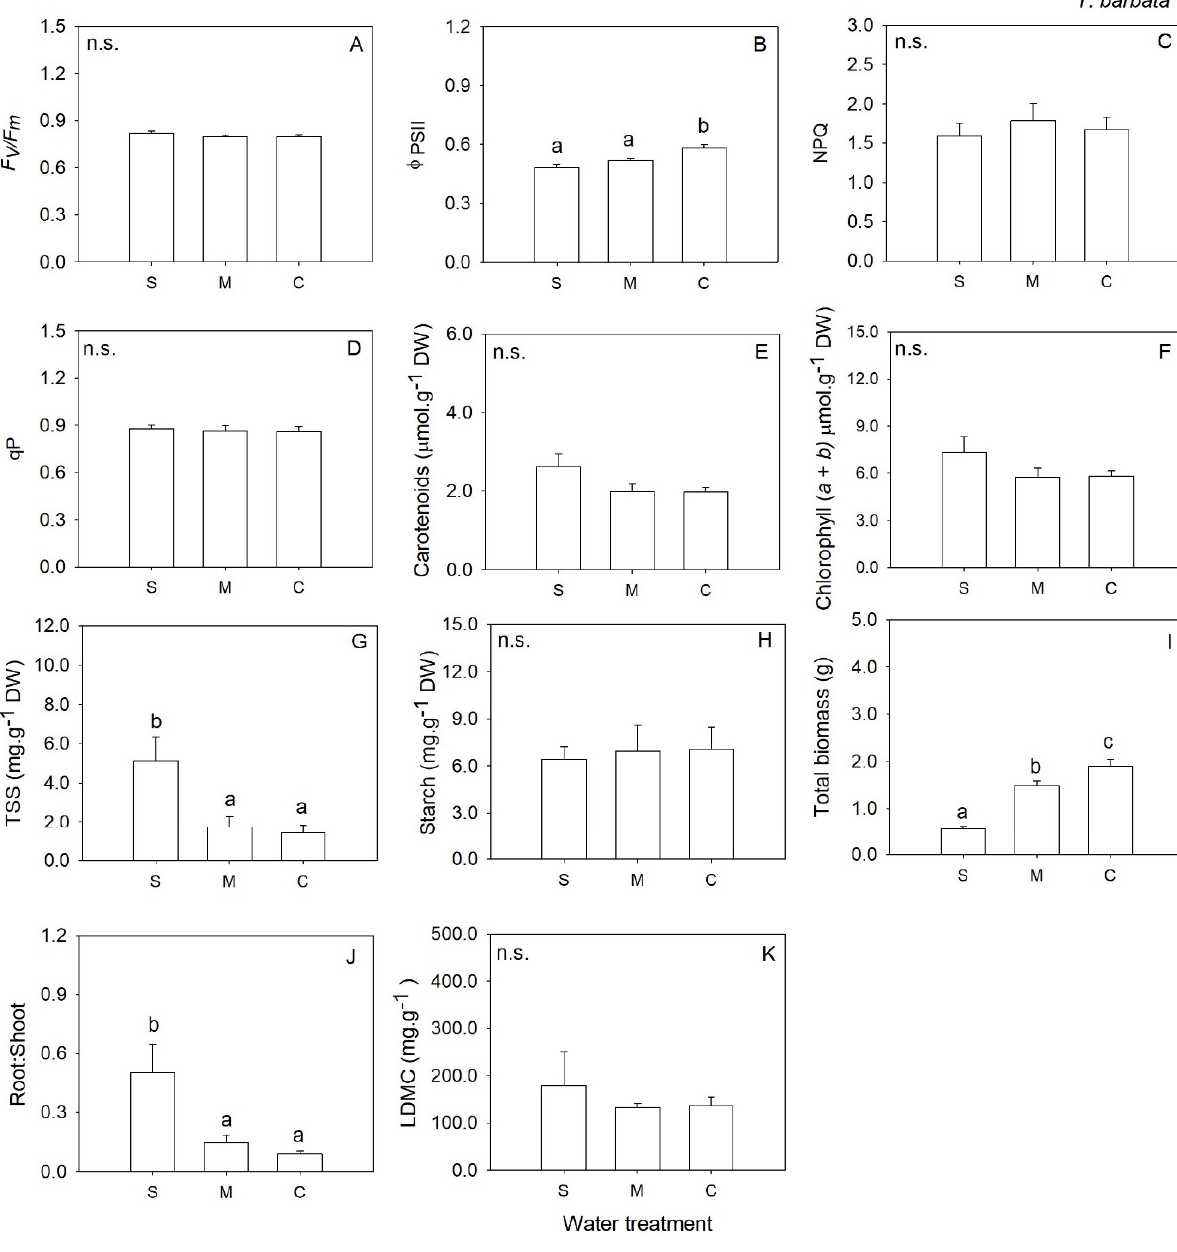
Figure 4. Mean values (+SE) of maximum quantum efficiency of photosystem II ( A ), the effective quantum efficiency of PSII ( B ), non-photochemical quenching ( C ), photochemical quenching ( D ), carotenoids content ( E ), chlorophylls ( a + b ) ( F ), total soluble sugars ( G ), starch content ( H ), total biomass ( I ), root to shoot biomass ratio ( J ) and Leaf Dry Matter Content ( K ) Tolpis barbata grown under severe water deficit (S), moderate water deficit (M) and control (C) conditions. Significant differences at p < 0.05 among treatments are indicated by different letters. n.s., not